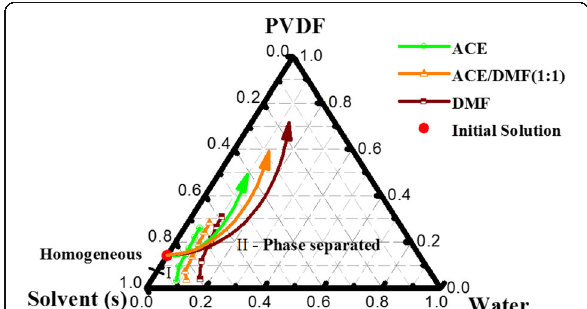
Fig. 8 Phase diagram of PVDF, solvent (s), and water at the relative humidity of 65%. The red point refers to the initial